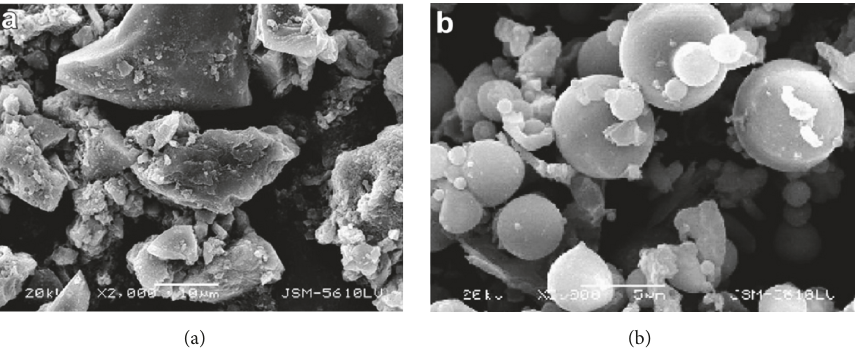
Figure 1: SEM images of coal bottom ash (a) and coal fly ash (b).